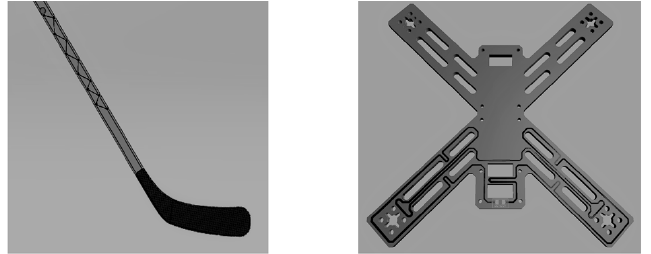
Figure 6. The concept system for failure detection.